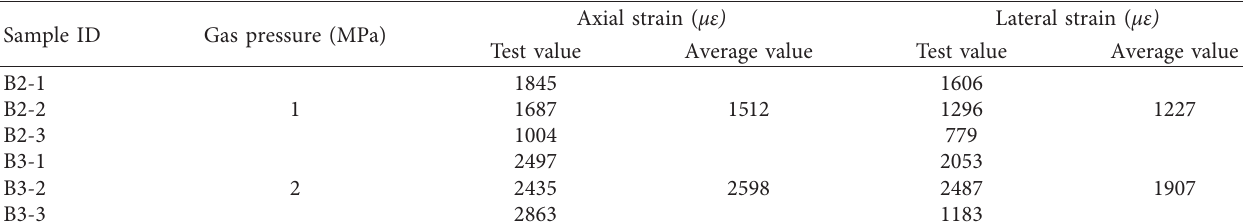
Table 4: The statistics of axial and lateral strain of the coal sample in the adsorption process.